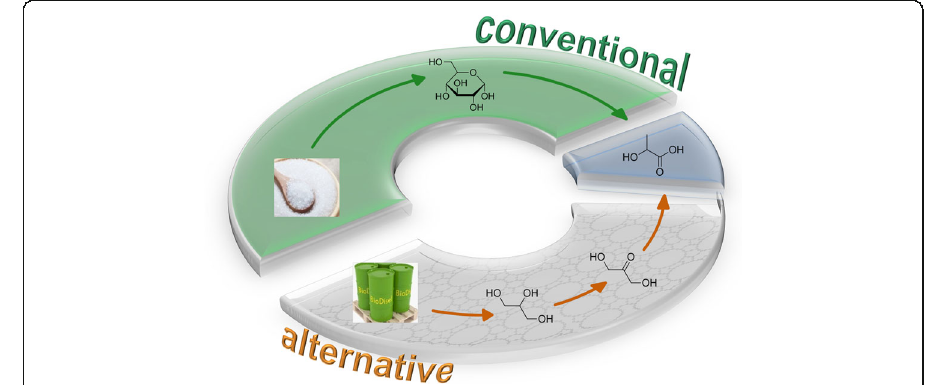
Fig. 1 Conventional and alternative lactid acid